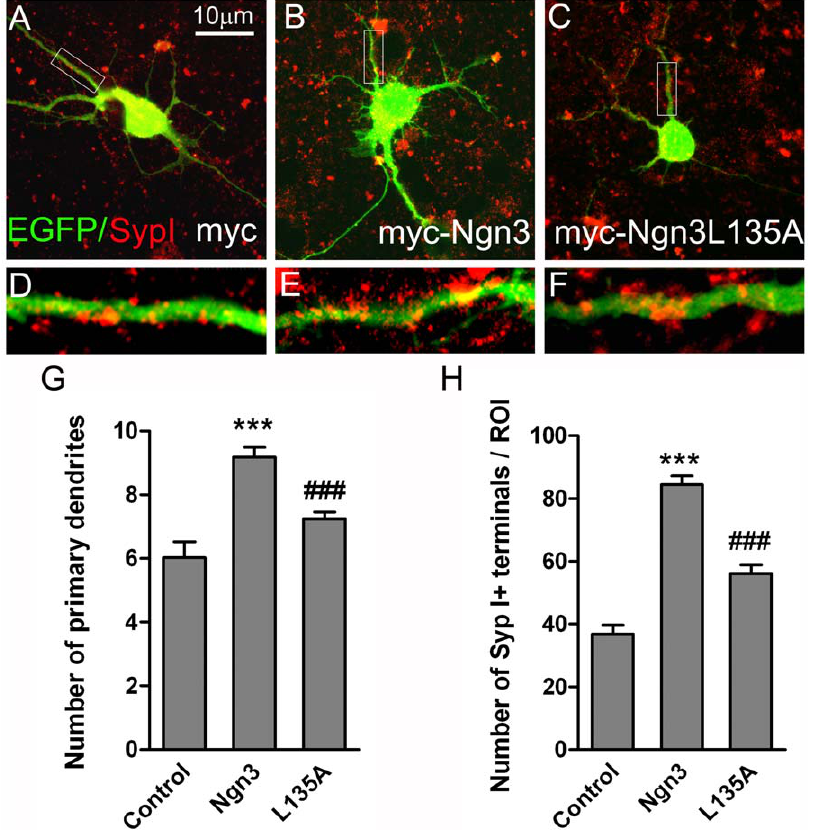
Figure 5. Mutation of the NES2 (L135A) counteracts the effects of Ngn3 overexpression on neuronal morphology and synaptic inputs. ( A–C ) Hippocampal neuronal cultures were co-transfected with constructs encoding EGFP and full-length myc-tagged wild-type Ngn3 (myc- Ngn3), Ngn3 with leucine 135 mutated to alanine (myc-Ngn3-L135A) or empty vector expressing myc-tag as control. After 16 h, double immunostaining was performed using an anti-GFP antibody to visualize transfected neurons and an anti-synaptophysin I antibody to determine the morphology and the total number of synapses of the transfected neurons. ( D–F ) Lower panels show the boxed regions at higher magnification ( G ) Number of primary dendrites of the transfected neurons. ( H ) Counts of synaptophysin I immunoreactive terminals in contact with a neuron within a circular region of interest (ROI) with a diameter of 100 m m and centered in the neuronal soma. Data are mean + s.e.m. and significance levels were determined using ANOVA followed by the Bonferroni post hoc test; *** p , 0.001 versus control neuron values and ### p , 0.001 versus myc-Ngn3 expressing neuron values. (Fig. 7C). Graphs in Figure 7 represent the relative amount of Ngn3 and the distribution of b III-tubulin in the pellet and in the soluble fraction under the two experimental conditions tested in vivo and in vitro. Quantitative data are shown as the mean and standard error (s.e.m.) and statistical analyses was assessed using unpaired t-test. The levels of significance were denoted as *p , 0.05, **p , 0.01.